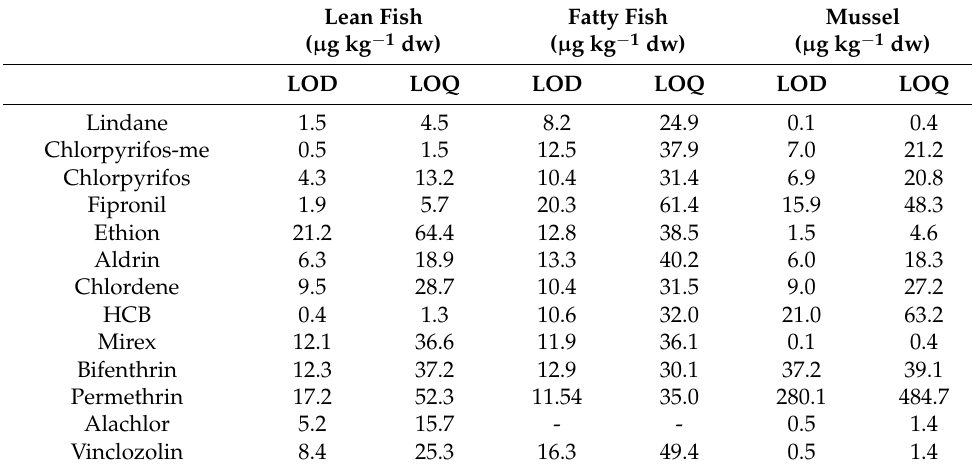
Table 6. LOD and LOQ for the three matrices.